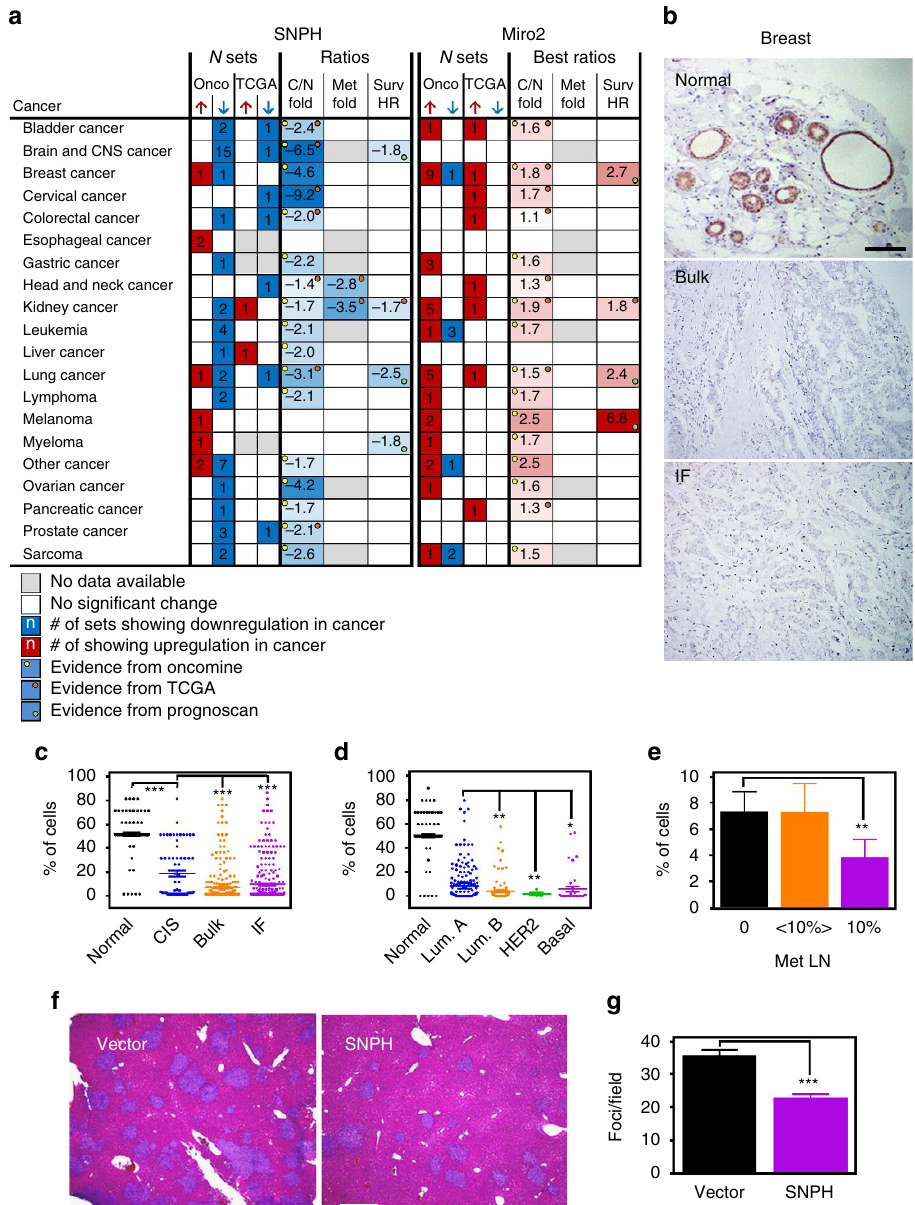
Figure 4 | SNPH controls tumour progression and metastasis. ( a ) Bioinformatics analysis of SNPH or Miro2 differential expression in cancer versus normal tissues in public databases (Oncomine, TCGA, Prognoscan). , upregulation; , downregulation; C/N, cancer/normal; HR, hazard ratio. ( b ) IHC analysis of SNPH expression in breast carcinoma versus normal breast epithelium. Bulk, main lesion; IF, invasive front. Scale bar, 100 m m. ( c ) SNPH-positive cells in normal breast, CIS, bulk breast carcinoma or invasive front (IF). Each point corresponds to individual patients. *** P o 0.0001 by unpaired t test with Welch’s correction. ( d ) SNPH-positive cells in molecular subtypes of breast cancer. Lum, luminal. HER2, HER2-enriched. Each point corresponds to individual patients. ** P ¼ 0.006–0.007; * P ¼ 0.01 by unpaired t test with Welch’s correction. ( e ) SNPH-positive cells in breast cancer with no lymph node metastasis, p 10% of metastatic lymph nodes ( o 10%) or 4 10% metastatic lymph nodes ( 4 10%). Data are represented as mean ± s.e.m. ** P ¼ 0.007 by Mann Whitney test. ( f ) Histologic analysis of liver metastases after intrasplenic injection of PC3 cells stably expressing vector or SNPH cDNA. Scale bar, 500 m m. ( g ) Number of liver metastatic foci per field in animals from f . Data are represented as mean ± s.e.m. ( n ¼ 15). *** P o 0.0001 by Student’s t test. were more prominently downregulated in the invasive front and nodes, compared with non-metastatic or low-metastatic cases bulk (core) lesions, compared with ductal carcinoma in situ (Fig. 4e). (Fig. 4c). Histologic subtypes of HER2-enriched and basal-like carcinoma also contained lower levels of SNPH than luminal A or luminal B cases (Fig. 4d). SNPH expression in breast cancer was independent of stage (Supplementary Fig. 7e) or histotype (Supplementary Fig. 7f), but was significantly more downregulated in metastatic tumours to loco-regional lymph (Fig. 4f,g). In contrast, stable overexpression of SNPH in these NATURE COMMUNICATIONS|7:13730|DOI: